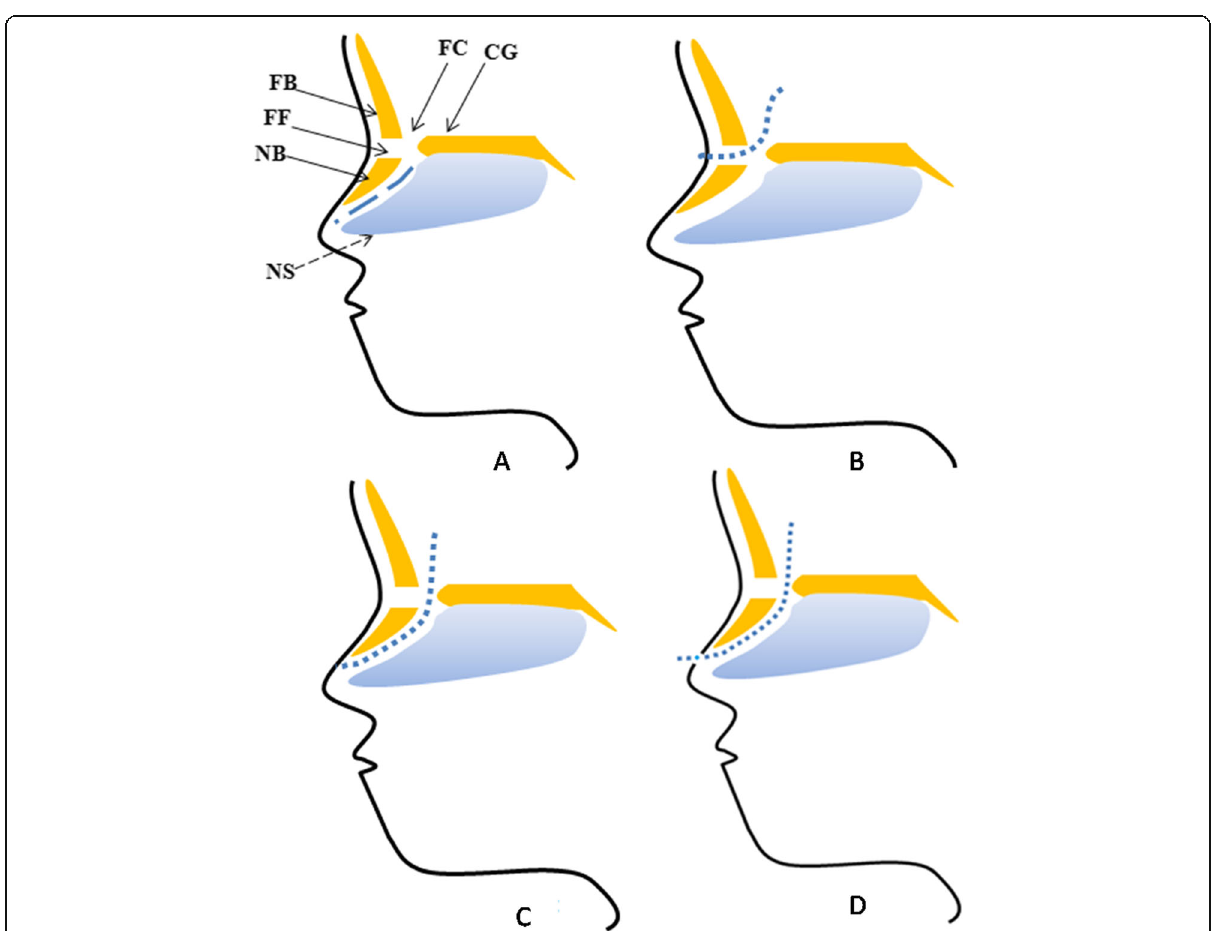
Fig. 1 Diagrams showing the anatomy of the nasofrontal region and its related pathologies. a Normal anatomy. Frontal bone (FB), fonticulus frontalis (FF), nasal bone (NB), nasal septum (NS), foramen cecum (FC), prenasal space (dotted line), and crista galli (CG). It is believed that during development, the dura mater projects through the fonticulus frontalis or more inferiorly into the prenasal space. This dural element normally regresses and its faulty regression leads to congenital nasofrontal masses. b Nasofrontal encephalocele. The dotted line shows the path for the development of nasofrontal encephalocele and has a connection with the intracranial structures. If there is no connection between herniated content and intracranial structures, it is called as extra-nasal glioma. c Nasoethmoidal encephalocele. The dotted line shows the path for the development of nasoethmoidal encephalocele and has a connection with the intracranial structures. If there is no connection between herniated content and intracranial structures, it is called an intra-nasal glioma. d Dural dermal sinus. Linear tract (dotted line) connecting intracranial structures to the dermal opening. Dermoid or epidermoid cysts may form along the dermal sinus tract due to the desquamation of tissue lining the